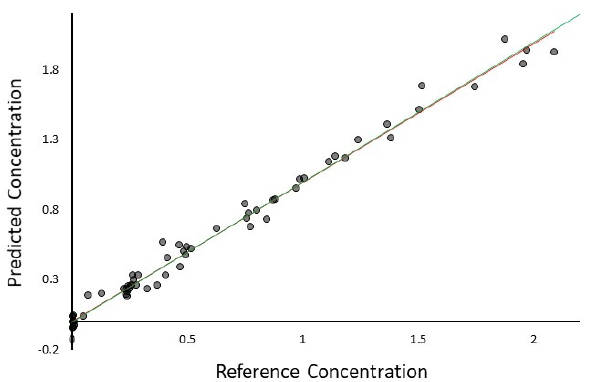
Figure 12. Typical comparison between the PLS-predicted values and the reference or ‘true’ ones. See text for the different studies that can be derived from